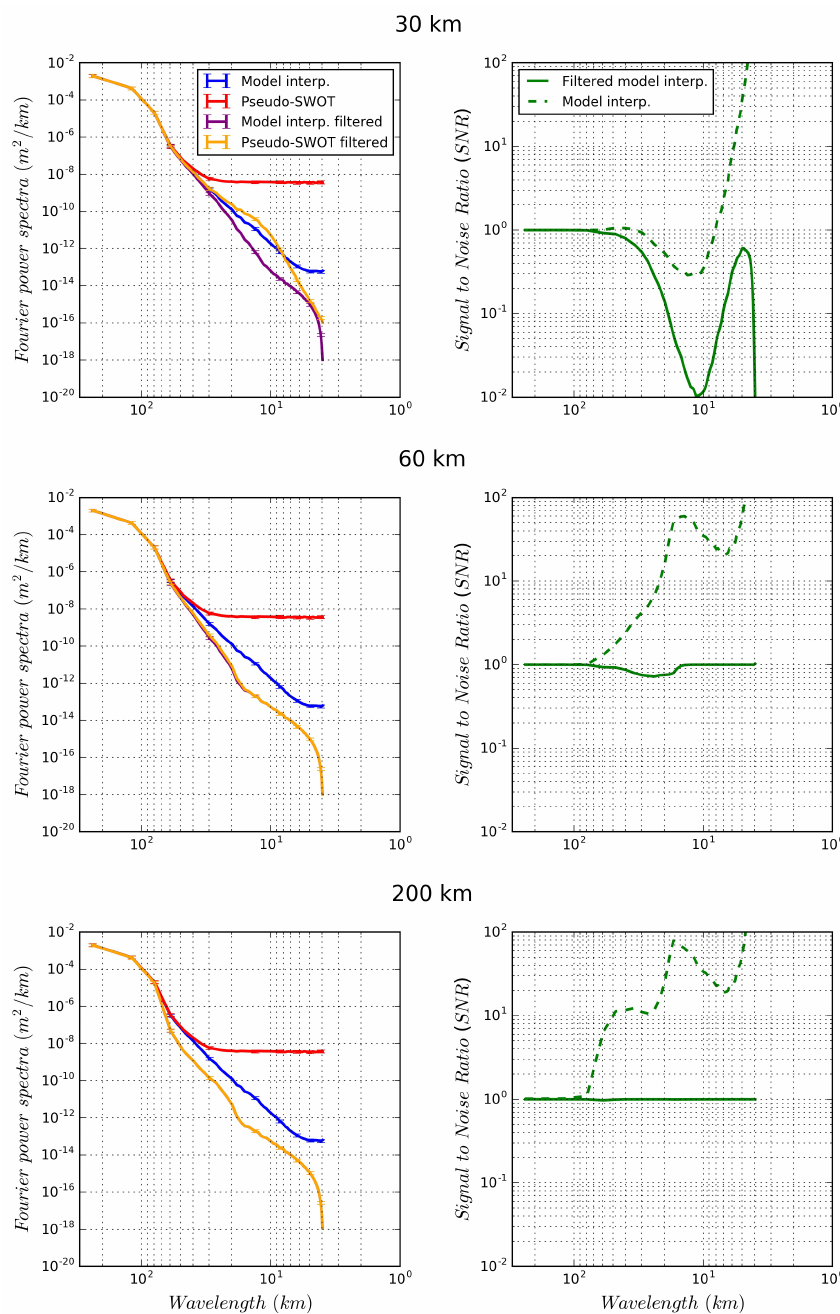
Figure 13. Box 1 region (pass 15) mean of cycles 1 to 122. ( Left ) Spectra of SSH model (blue) and SSH obs (red) before filtering and after applying the different cut-off wavelengths shown in the different rows (30, 60 and 200 km) in purple and orange, respectively. Error bars denote 95% confidence intervals. ( Right ) SNR of SSH model and SSH obs , both filtered (solid line) and of SSH model non-filtered and filtered SSH obs (dashed